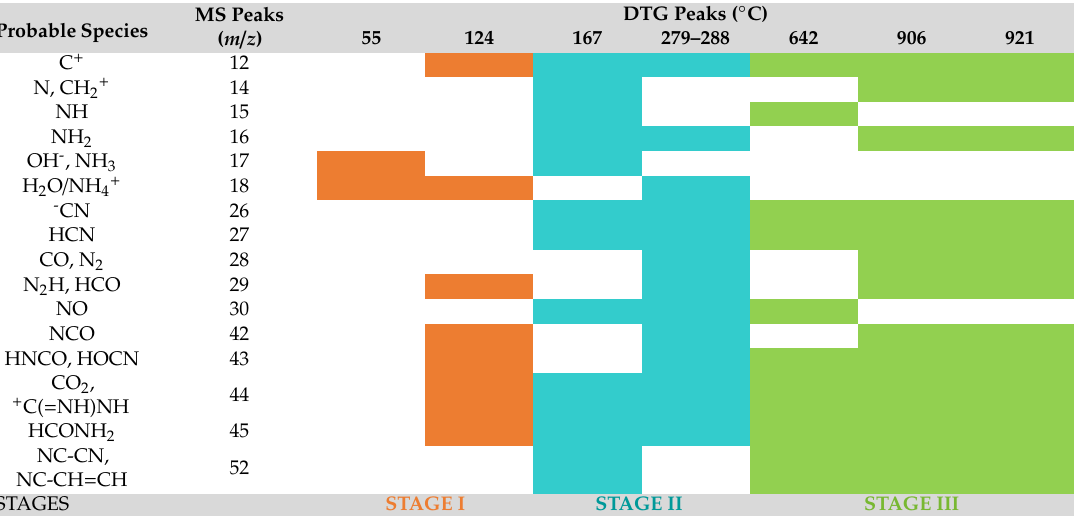
Table 2. Summary of detected feasible volatile species associated with each stage of thermal decomposition and fragmentation processes of HCN-derived thermal polymer